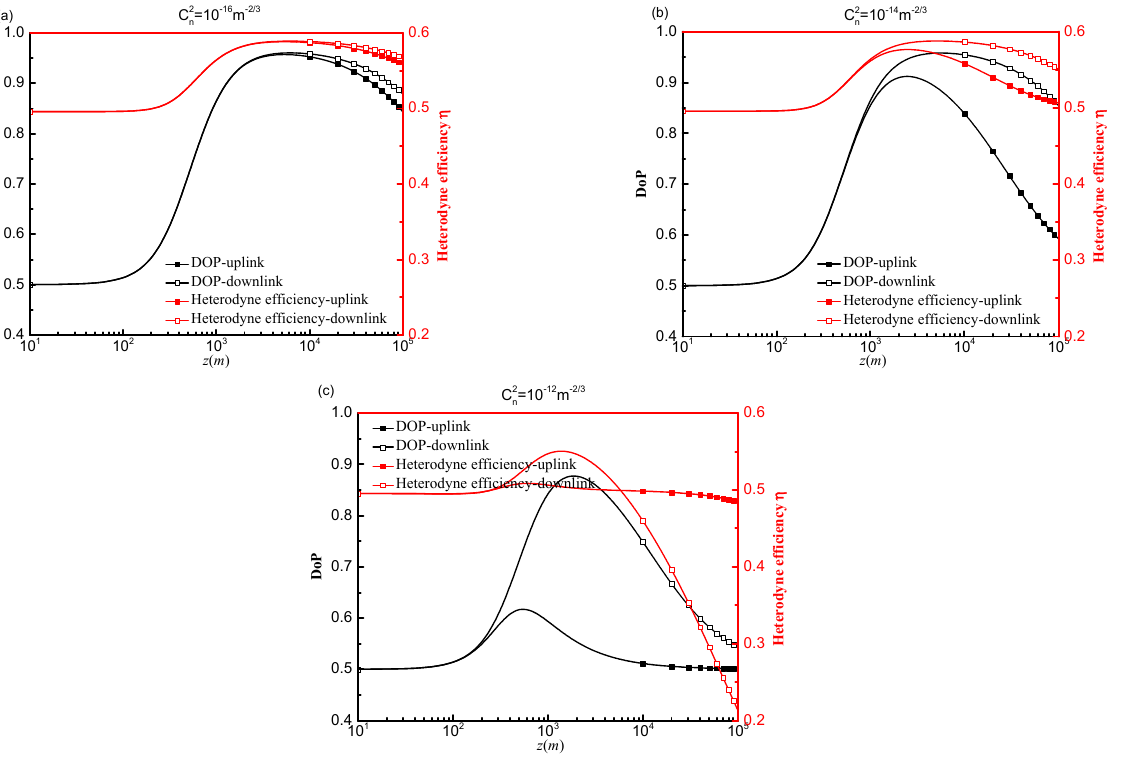
Figure 7. Effect of atmospheric turbulence intensities on the heterodyne efficiency and DoP on an uplink path and a downlink path ( a ) C 2 n = 10 − 12 m − 2/3 ( b ) C 2 n = 10 − 14 m − 2/3 ( c ) C 2 n = 10 − 16 m − 2/3 . For various transmission distances, Figure 8 illustrates the heterodyne efficiency as a function of detector aperture D. As shown in Figure 8, the heterodyne efficiency of a downlink path and an uplink path decreases with increasing detector size. The heterodyne efficiency of a downlink path is also higher than that of an uplink path. Additionally, the heterodyne efficiency increases with an increasing transmission distance on a downlink path and an uplink path. This is due to the fact that the zenith angle decreases as the transmission distance increases, the corresponding atmospheric turbulence intensities decrease, spatial coherence deteriorates and the impact of atmospheric turbulence on the beam is reduced.